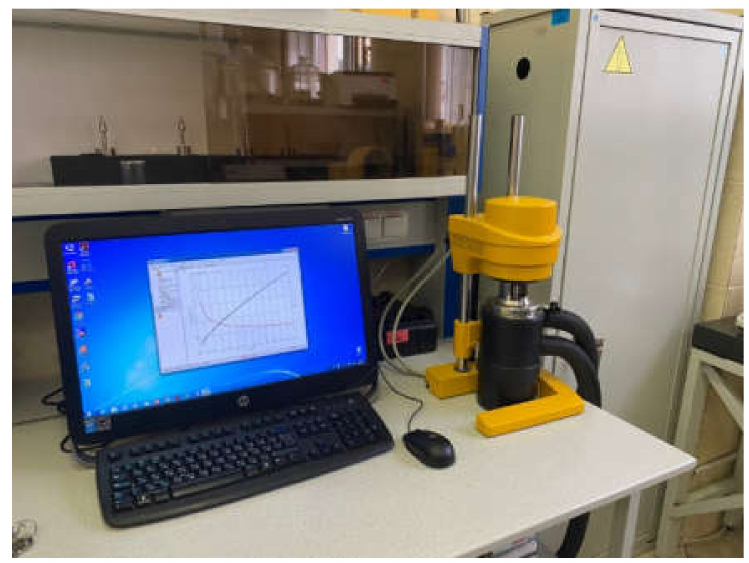
Figure 1. Rotary viscometer “Rheotest RN 4.1”.